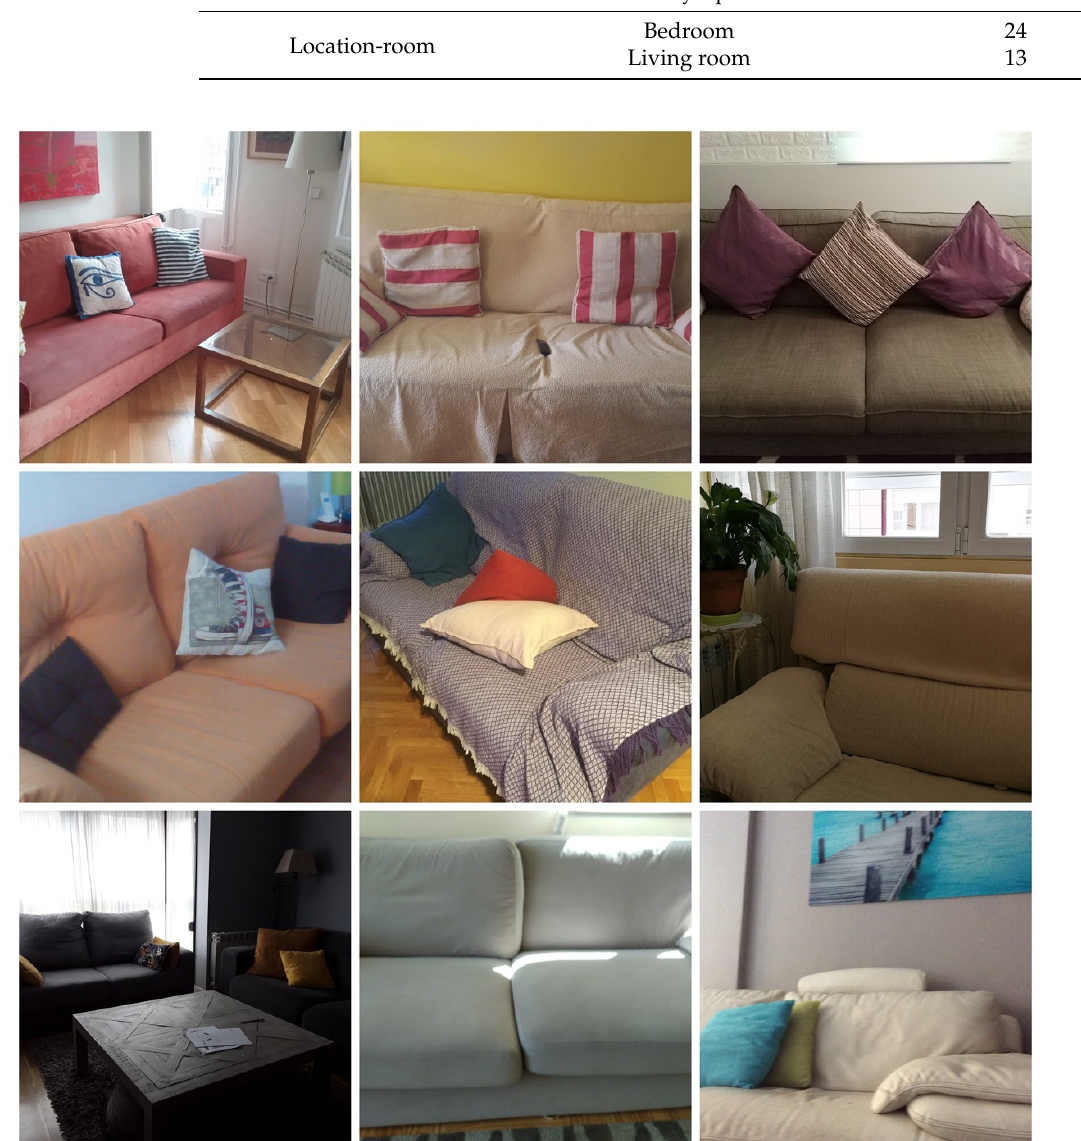
Figure 3. Comfortable spaces, referring to living rooms, and specifically, sofas.